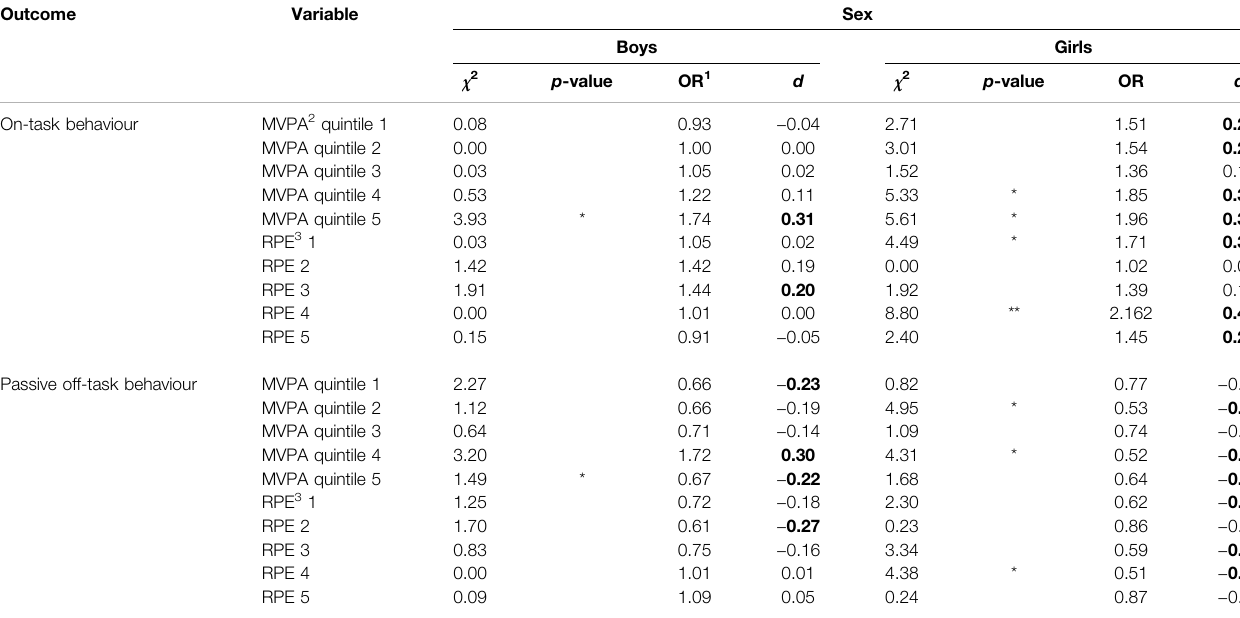
TABLE 7 | Response of task-behaviour to objective and subjective PA by sex. Outcome